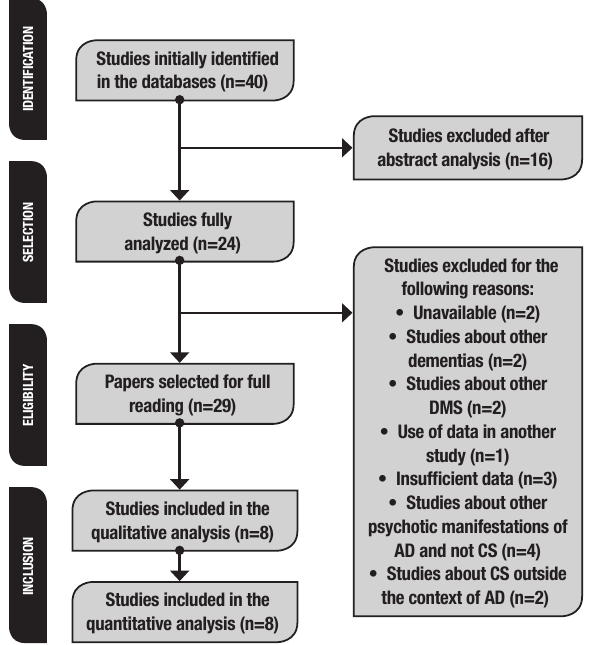
Figure 1. Study selection and inclusion